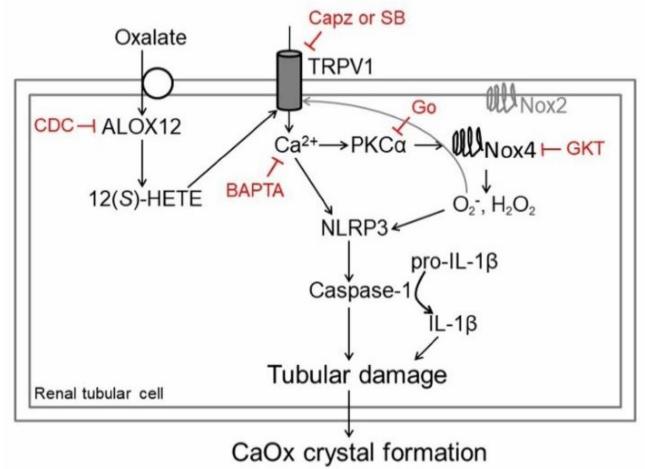
Figure 9. Schematic diagram showing how TRPV1 hyperfunction contributes to tubular dam- age in hyperoxaluria. After uptake by tubular cells, oxalate overstimulates TRPV1 via an en- hanced function of arachidonate 12-lipoxygenase (ALOX12) on synthesis of endovanilloid 12( S )- hydroxyeicosatetraenoic acid [12( S )-HETE]. Blockade of ALOX12 by cinnamyl-3,4-dihydroxy- α - cyanocinnamate (CDC) decreases 12( S )-HETE. TRPV1 hyperfunction induces intracellular Ca 2+ elevation, increasing PKC α activity, as confirmed by Ca 2+ chelating effect of BAPTA. PKC α sub- sequently triggers NADPH oxidase (Nox) 4 but not Nox2 activation, which is attenuated by PKC inhibition (Gö 6976, Go). Superoxide (O 2 − ) and hydrogen peroxide (H 2 O 2 ) are liberated and result in oxidative stress, attenuated by Nox inhibition (GKT137831, GKT). ROS generated by Nox4 may also activate TRPV1. Tubular damage is further evidenced by increased inflammasome NLR family pyrin domain-containing 3 (NLRP3) expression, caspase-1 activation, and maturation of IL-1 β for secretion. Besides TRPV1 inhibition, blockade of more downstream effectors such as Nox4-mediated oxidative stress and Ca 2+ chelation attenuates oxalate- or hyperoxaluria-induced tubular cell